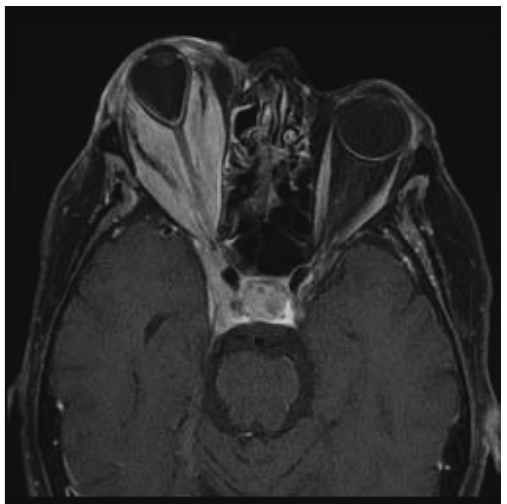
Figure 2: Axial enhanced T1 MRI demonstrating marked proptosis, stretching of the optic nerve, and diffuse enhancement extending into the right cavernous sinus.